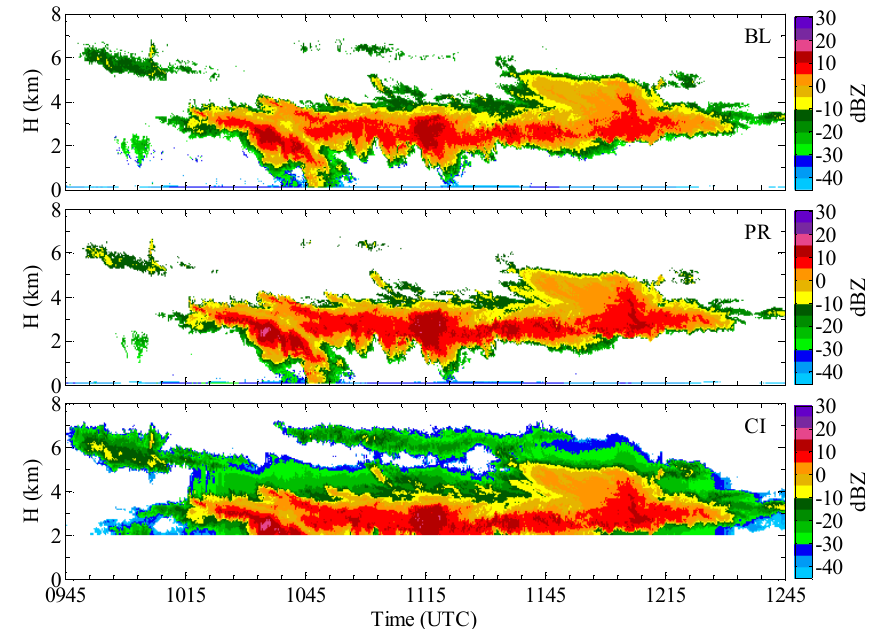
Figure 2. An example of 3-h time-height cross-sections of reflectivity from all three operational modes observed on 20 July 2015. In the figure, CI, BL, and PR are cirrus mode, boundary mode, and precipitation mode, respectively.